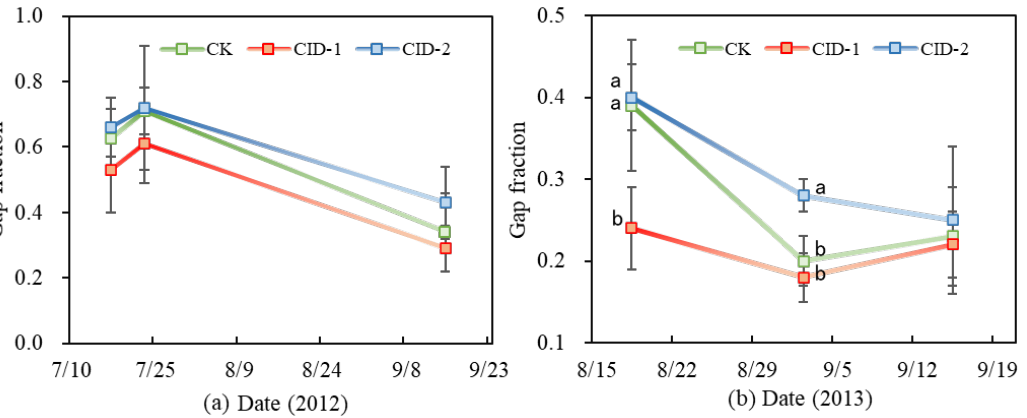
Figure 3. Effects of irrigation regimes on gap fraction (fGPAR) under different irrigation regimes during the rice growing season of ( a ) 2012 and ( b ) 2013. The date in the abscissa axis, for example 7/10, represent 10 July. Data are means ± SE of six replicates. The different letters on the tops of symbols during the same growth date indicate significant differences between treatments at 5% according to Duncan’s multiple range test. The different letters were shown only when significant differences were detected.